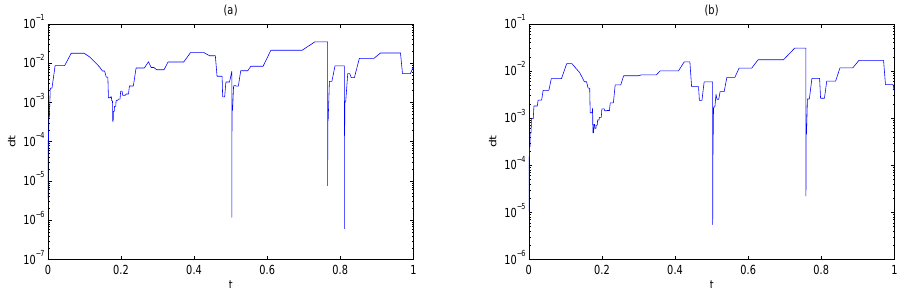
Figure 4. The time step sizes for Burgers equation with n = 1 applying Huang’s method ( a ) and the proposed method ( b